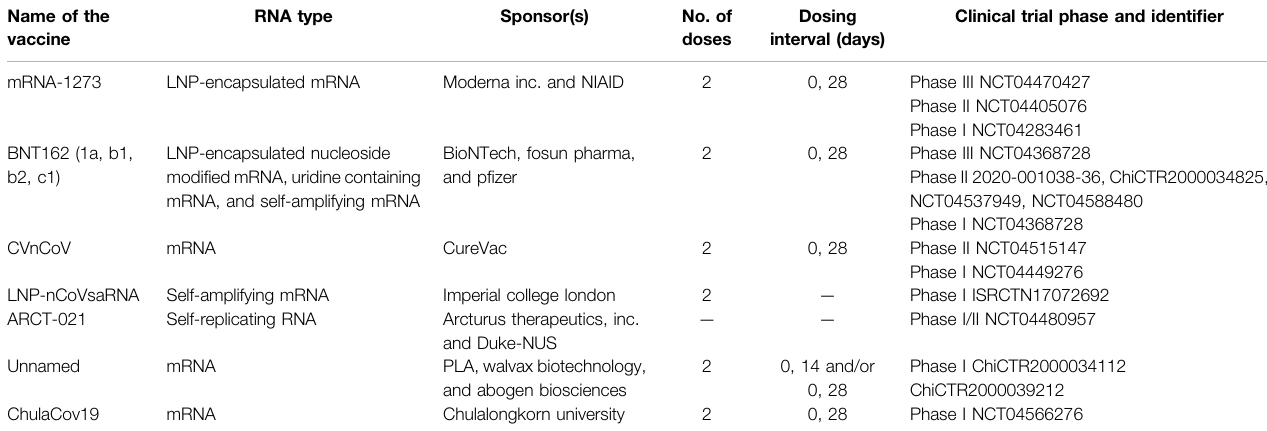
TABLE 1 | Examples on potential RNA-based COVID-19 vaccine candidates currently undergoing clinical